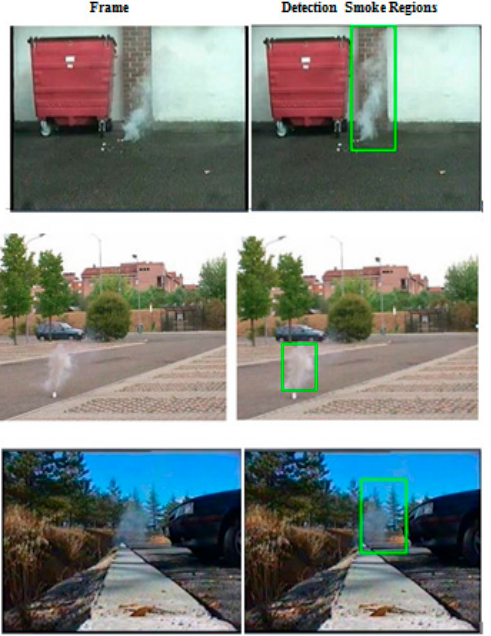
Figure 7. Some results of smoke regions localization.